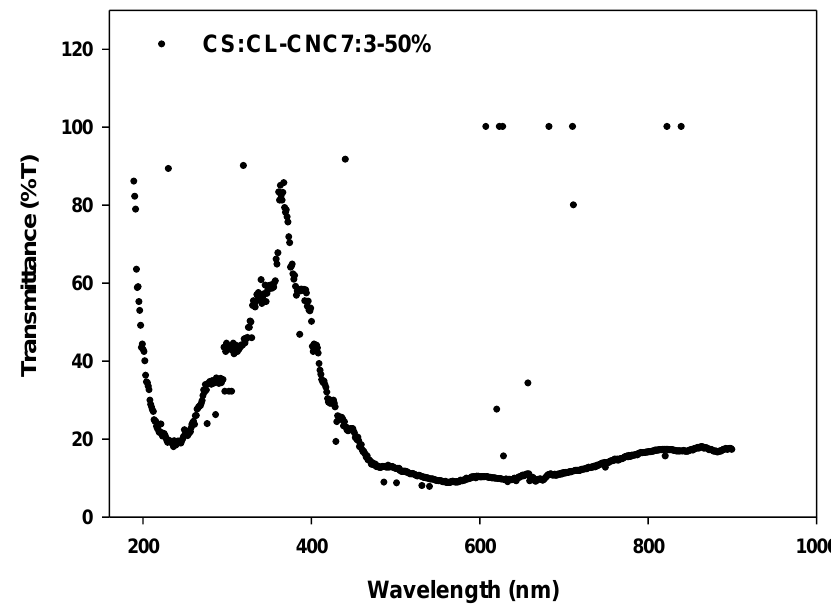
Figure 4. UV-visible transmittance % spectra of CS:CL-CNC 7:3-50% bio-composite film.